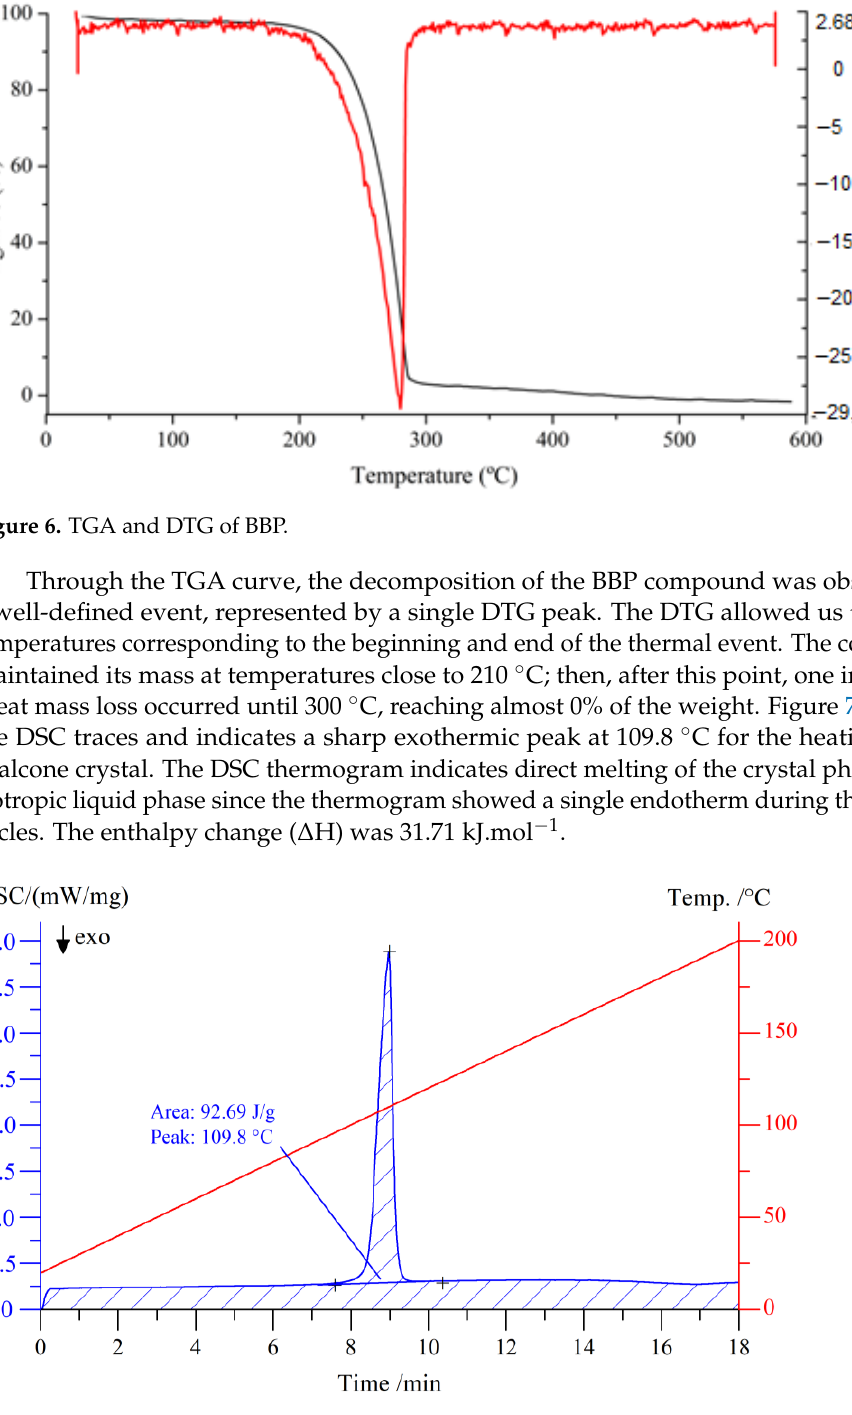
Figure 7. DSC measurement of BBP.